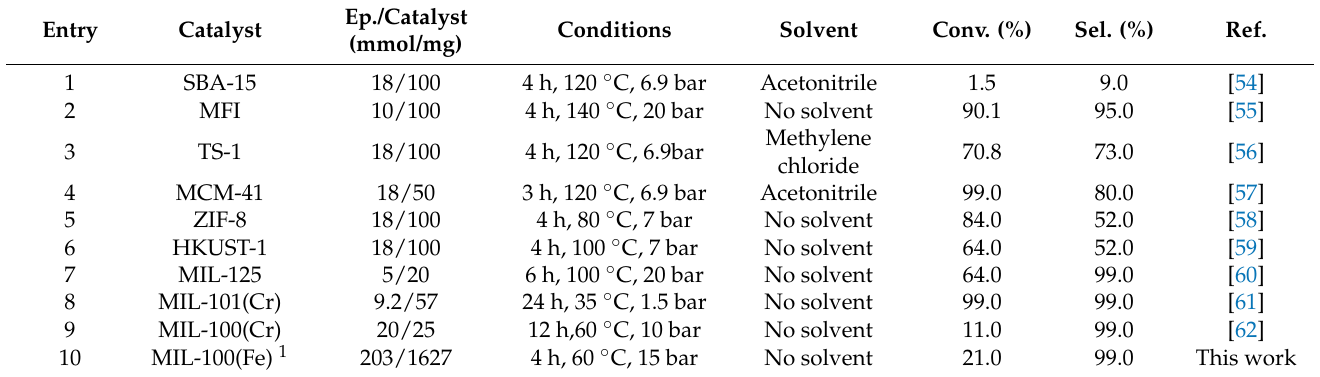
Table A2. Comparison of catalytic performance of reported mesoporous materials in the fixation of CO 2 in